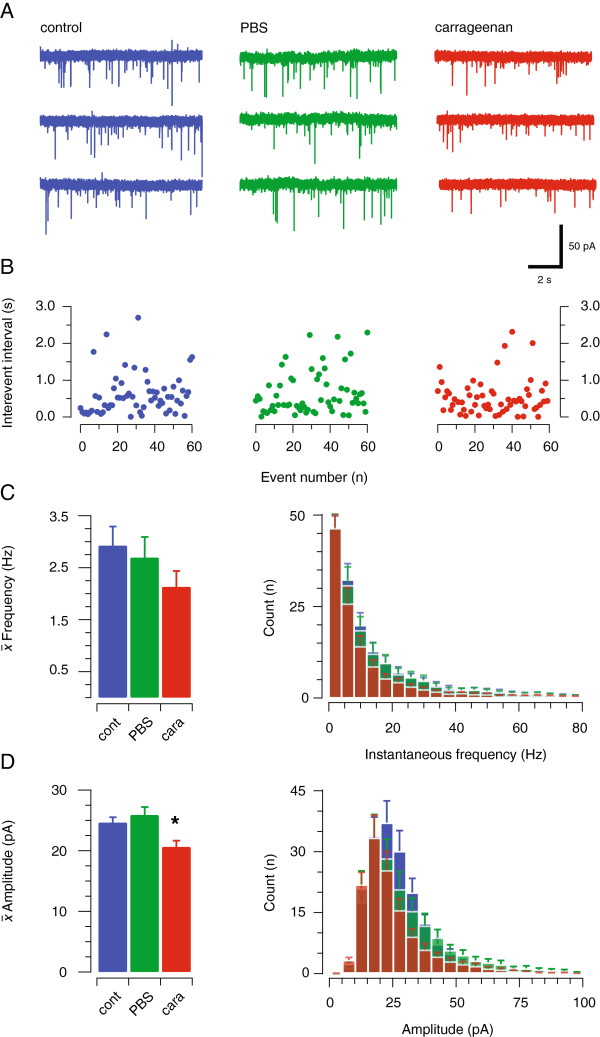
Excitatory synaptic drive is altered in the upper cervical dorsal horn by acute neck muscle inflammation. A. Raw data showing representative spontaneous excitatory postsynaptic currents (sEPSCs, 30 s of continuous data) in SDH neurons from control, sham, and carrageenan-injected animals. sEPSCs were blocked by CNQX (10 μM, not shown). B. Stationary plots of sEPSC interevent interval (IEI) for the control, sham, and carrageenan-injected recordings shown in A. Note that these plots do not contain any time dependent trends, or tight clustering of data points that would indicate sEPSC bursting. C. Group data showing mean (left) and instantaneous (right) sEPCS frequency were similar in control, sham, and carrageenan-injected animals. D. Group data shows sEPCS amplitude (left) was significantly reduced in carrageenan-injected animals. Overlaid average sEPSC amplitude histograms (right) show a leftward shift in the distribution for carrageenan-injected animals.